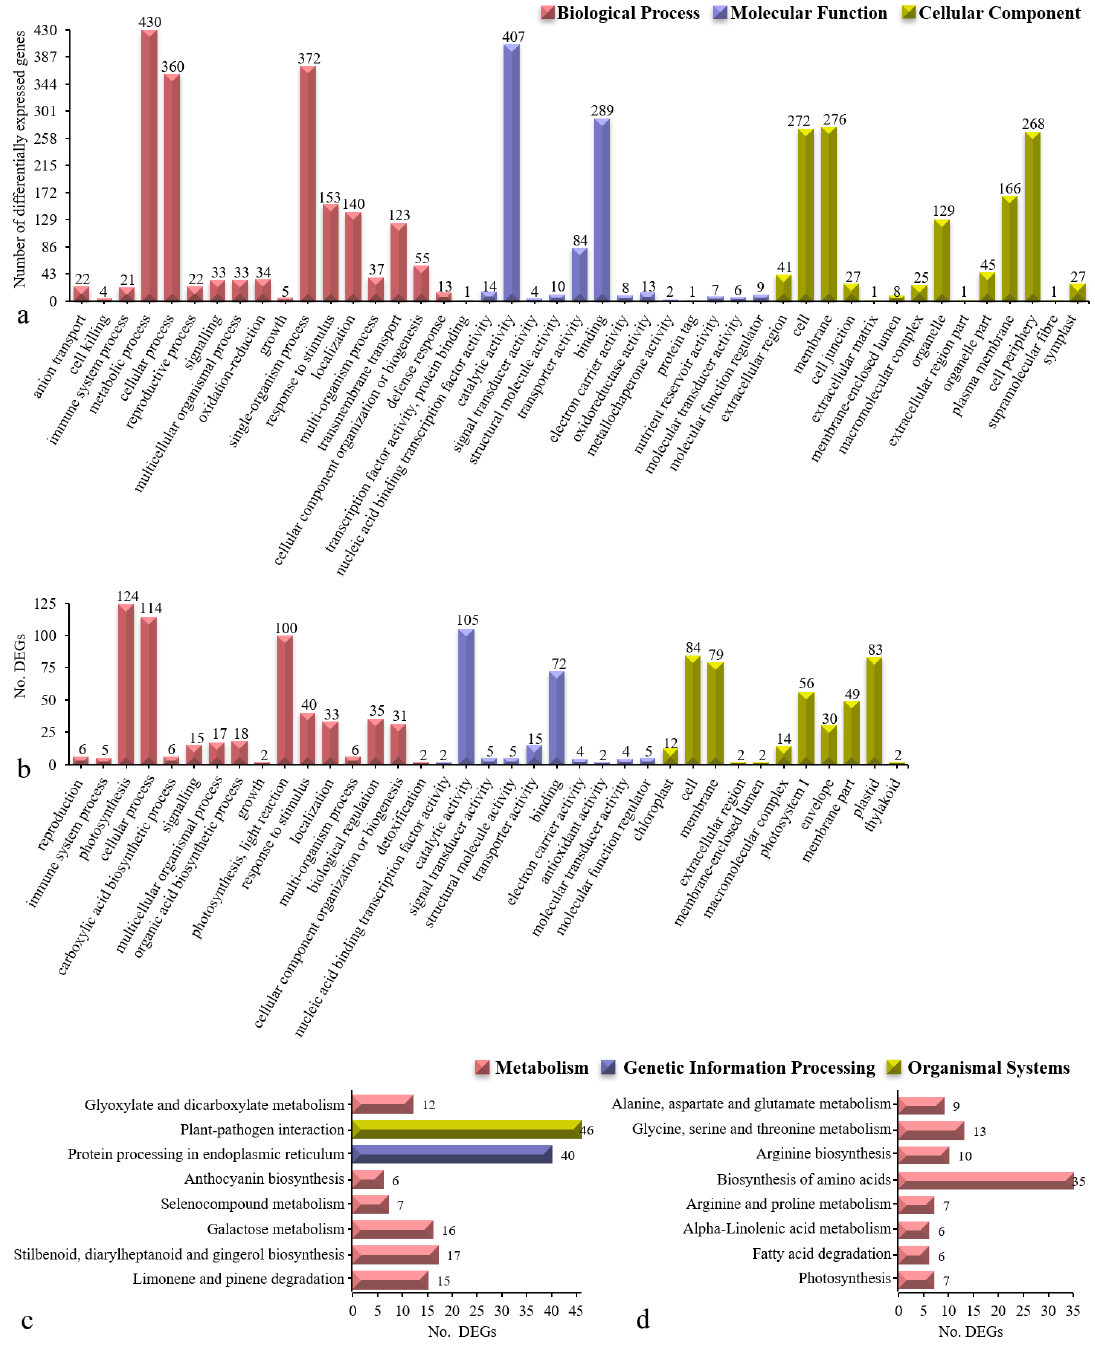
Figure 8. GO terms and Kyoto Encyclopedia of Genes and Genomes (KEGG) pathway distributions in cluster III ( a , c ) and cluster X ( b , d ). In ( a , b ) , x -axis indicates each GO term, and the y -axis indicates the number of DEGs in ( c ) and ( d ) indicates the number of DEGs, and the y -axis indicates each pathway. The three colors in ( a , b ) indicate the GO terms belonging to the biological process (red), molecular function (purple), and cellular component (light green) categories. The three colors in the pathways in ( c ) and ( d ) represent metabolism (red), genetic information processing (purple), and organismal systems (light green). The number above/to the right of each bar indicates the number of DEGs assigned to that GO term or pathway.